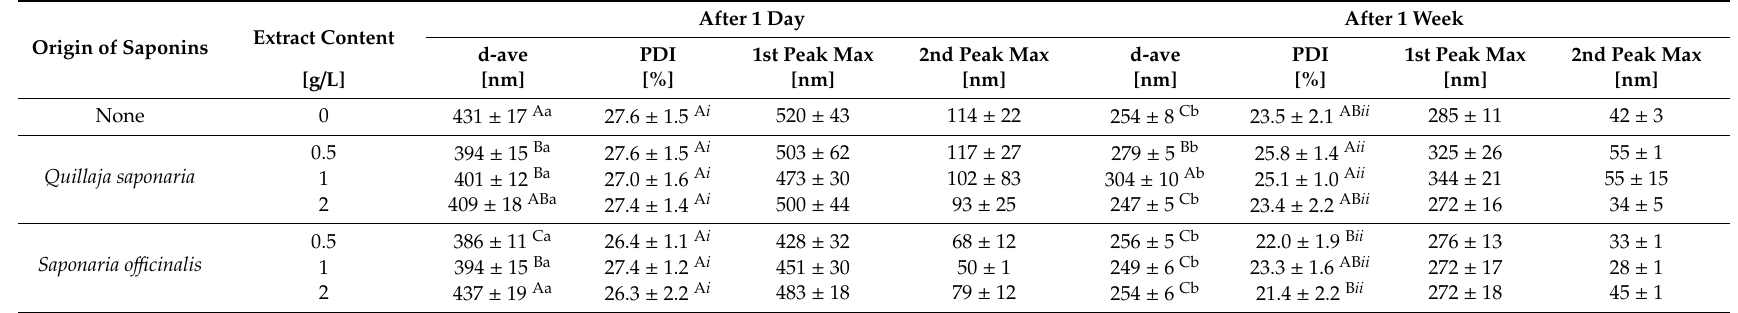
Table 1. Emulsion droplet size values and Polydispersity Index (PDI) determined after 1 day and 1